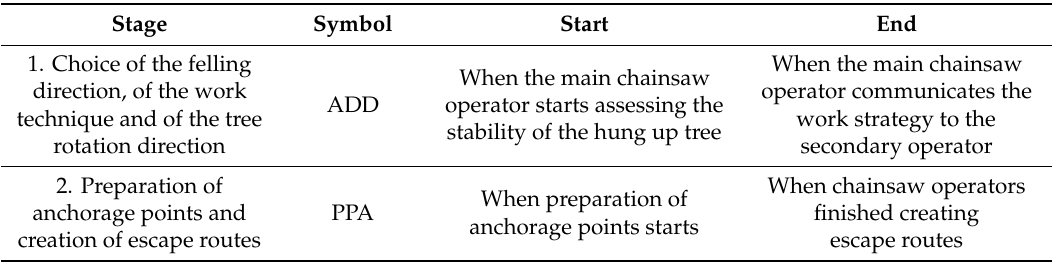
Table 2. Stages in the felling of hung up